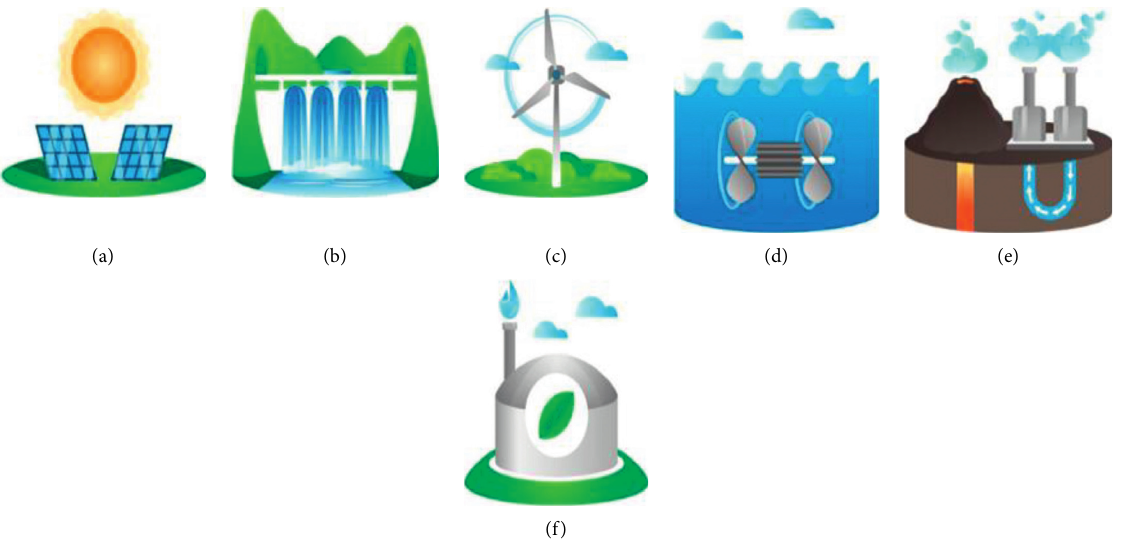
Figure 1: Types of green energy. (a) Solar. (b) Hydro. (c) Wind. (d) Tidal. (e) Geothermal. (f)